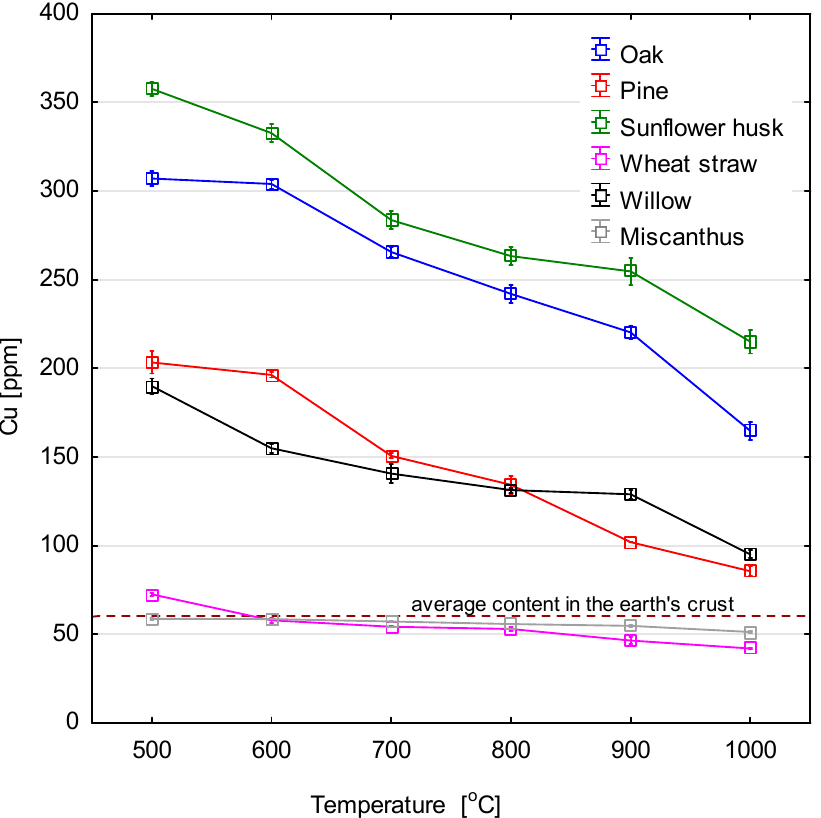
Figure 5. Changes in Cu content in the examined biomass depending on ash-forming temperature.